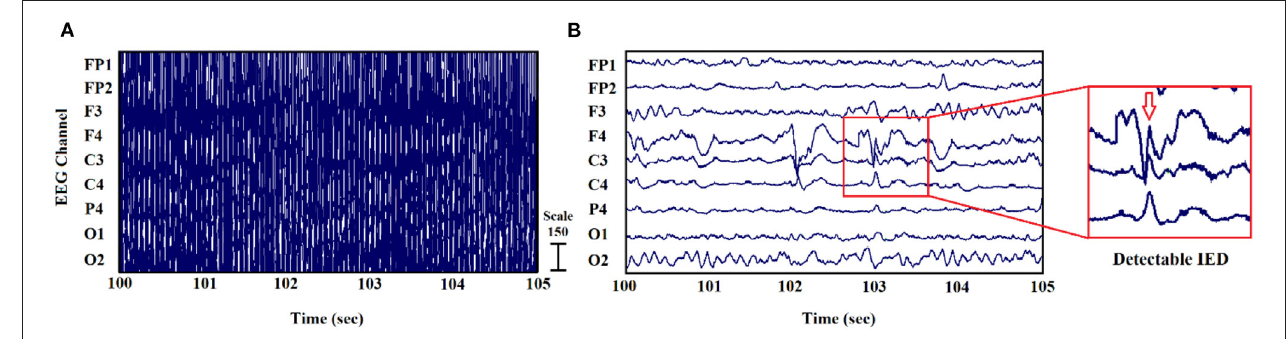
FIGURE 2 | EEG signal recorded inside the MR scanner: (A) before and (B) after the elimination of gradient and BCG artifacts (24).